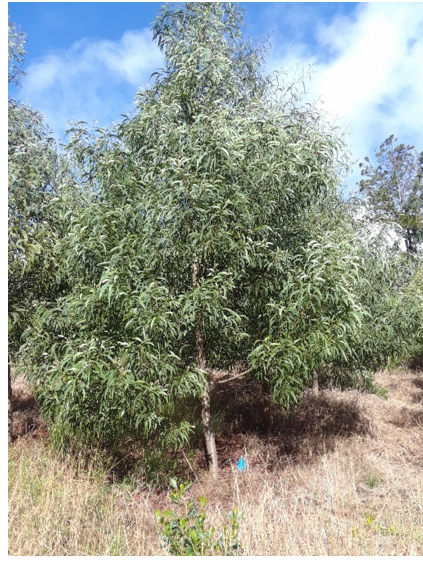
Figure A2. Koa sapling at 24 months at the Kokee site.